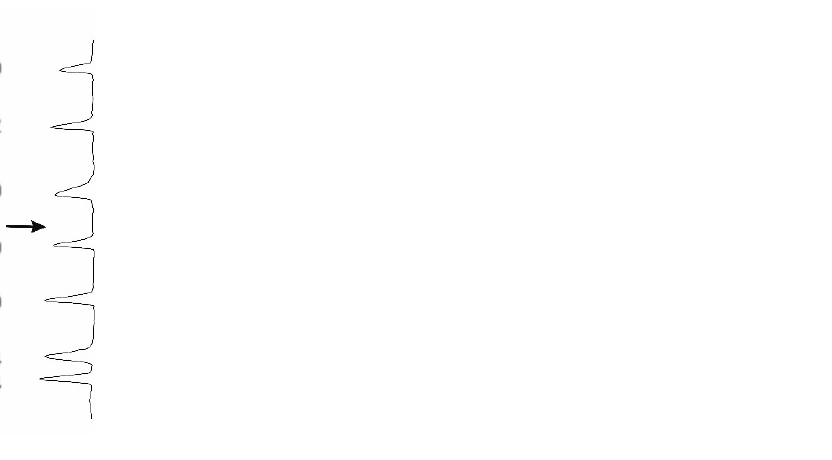
Figure 2. Example of converting the electrophoretic profile of a protein marker into a densitogram using the Chrom & Spec software.